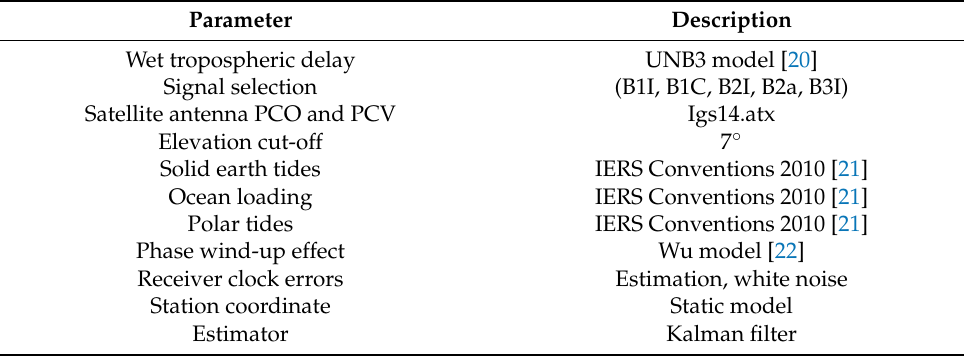
Table 2. Detailed strategy of PPP